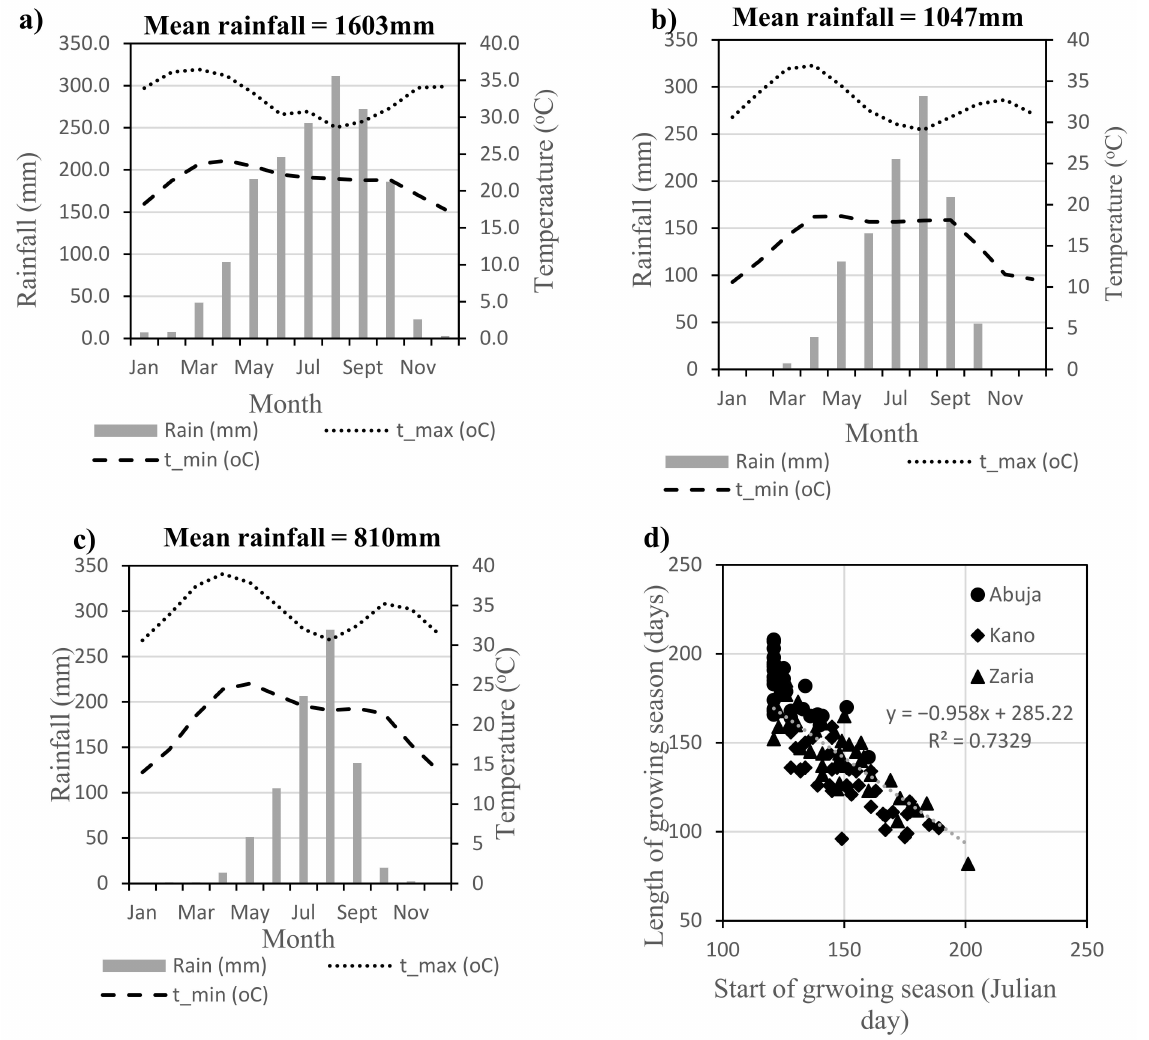
Figure 1. ( a – d ) - Cumulative monthly rainfall and temperature over a 31–year period (1985–2015) for Abuja ( a ), Zaria ( b ), Kano ( c ) and Start and length of growing ( d ) Source of data: NIMET,